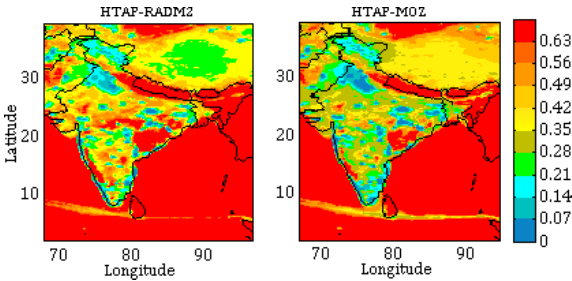
Figure 10. Net daytime surface CH 2 O to NO y ratio in simulations with different chemical mechanisms for the month of April during